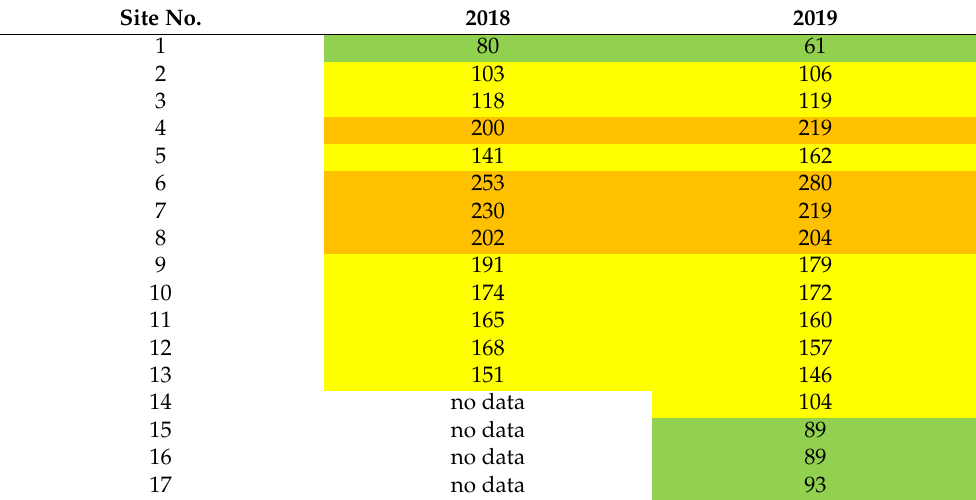
Table 5. The WQIs calculated based on the annual average